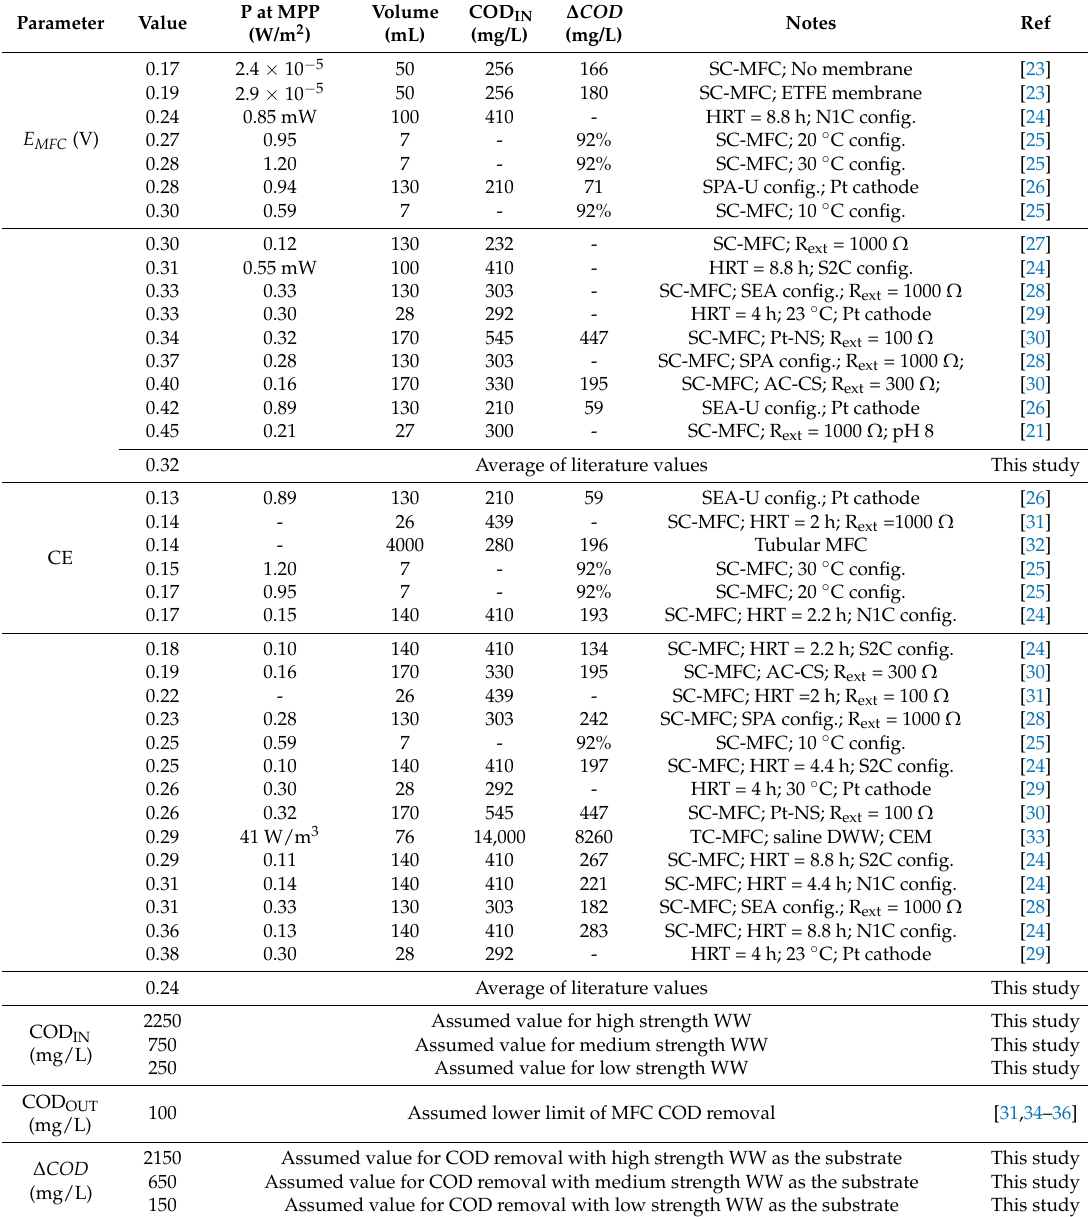
Table 1. Summary of typical MFC cell voltages ( E MFC ) and Coulombic Efficiencies ( CE ) for MFCs treating real wastewater and assumed COD removals for high, medium and low strength wastewaters. Maximum Power Point values (MPP) are provided for